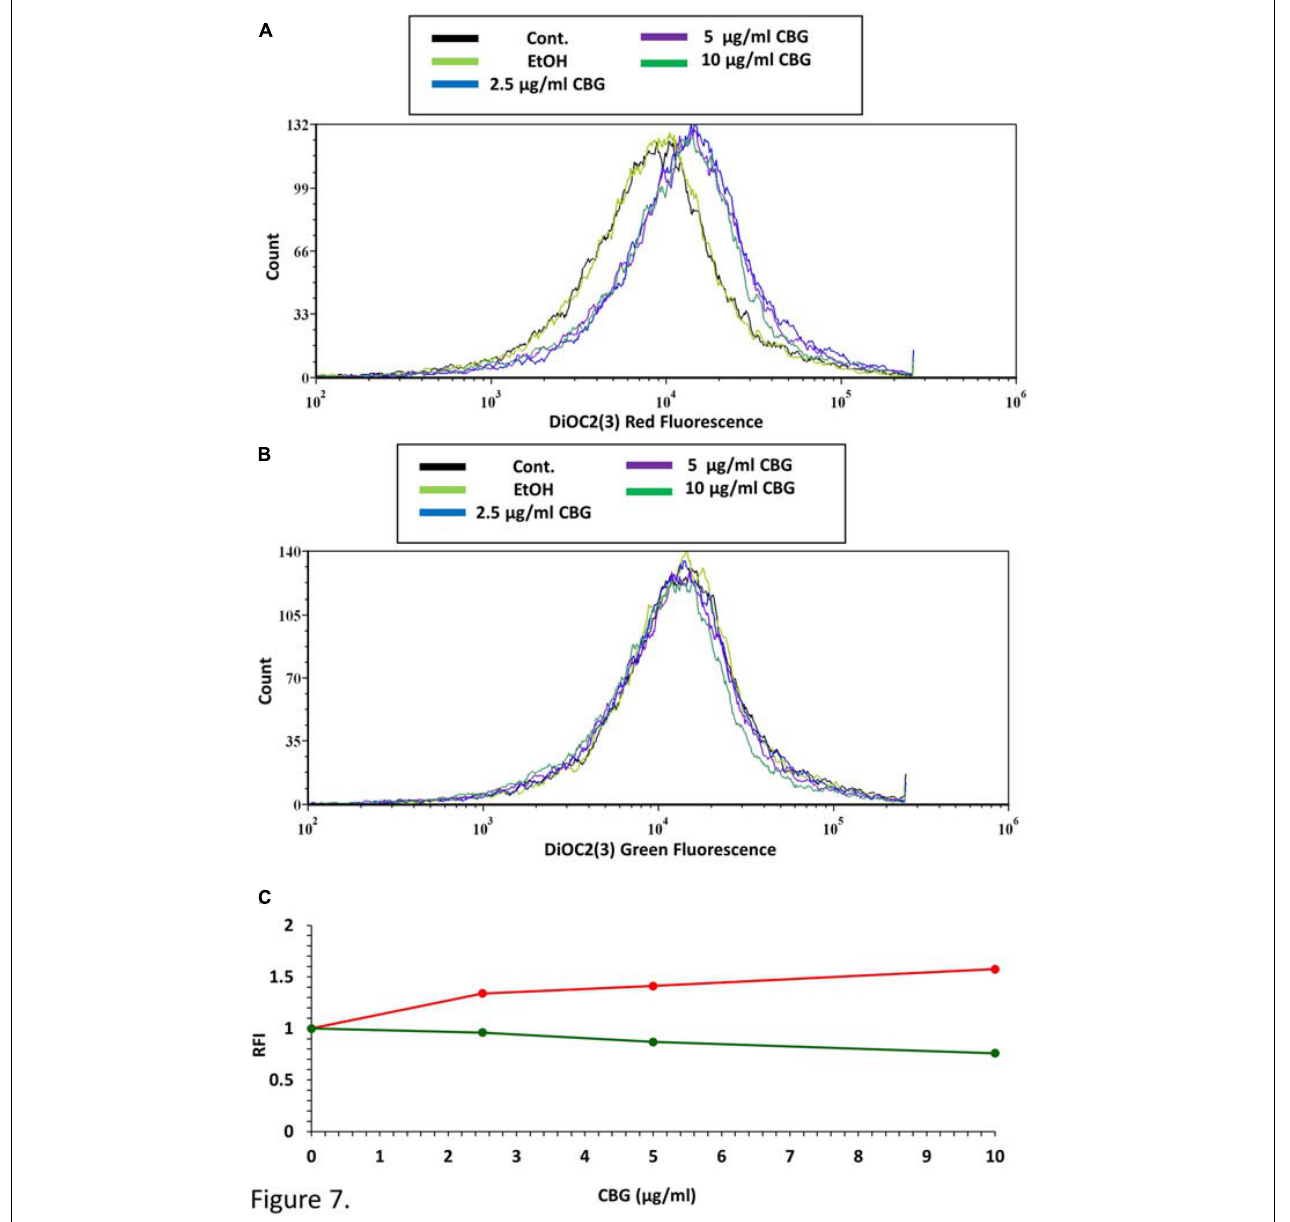
FIGURE 7 | CBG causes membrane hyperpolarization in S. mutans . (A) The red fluorescence of DiOC2(3)-stained S. mutans that have been exposed to different CBG concentrations (0–10 µ l/ml) for 30 min. (B) The green fluorescence of DiOC2(3)-stained S. mutans that have been exposed to different CBG concentrations (0–10 µ l/ml) for 30 min. (C) The relative fluorescence intensity (RFI) of the red (red lines) and green (green lines) fluorescence of the samples presented in (A,B)